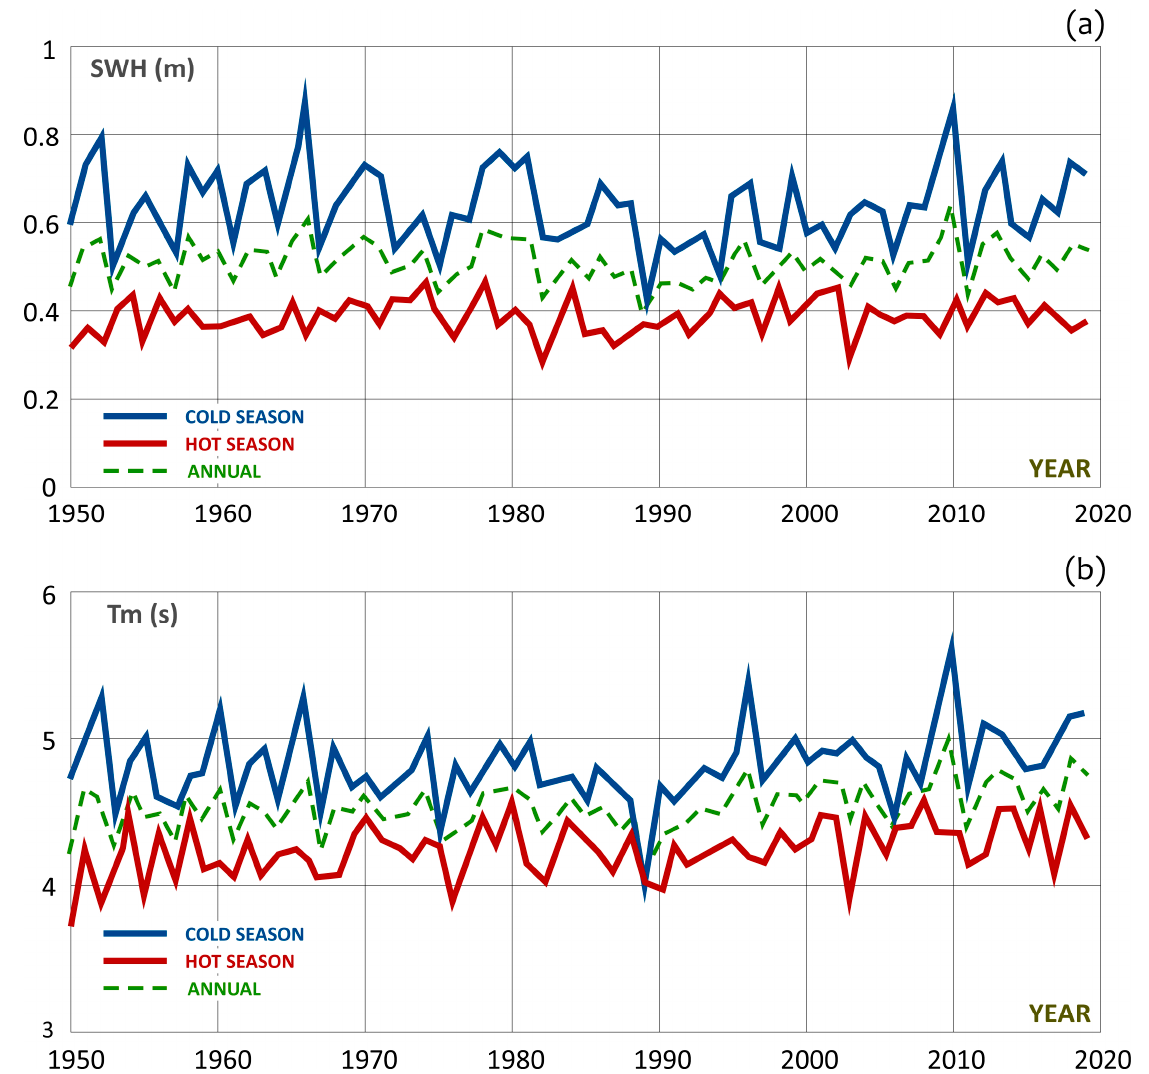
Figure 8. ERA5, dataset 1950–2019. Cold (blue) and hot (red) seasons: SWH ( a ) and Tm ( b ). Green dashed lines represent the annual